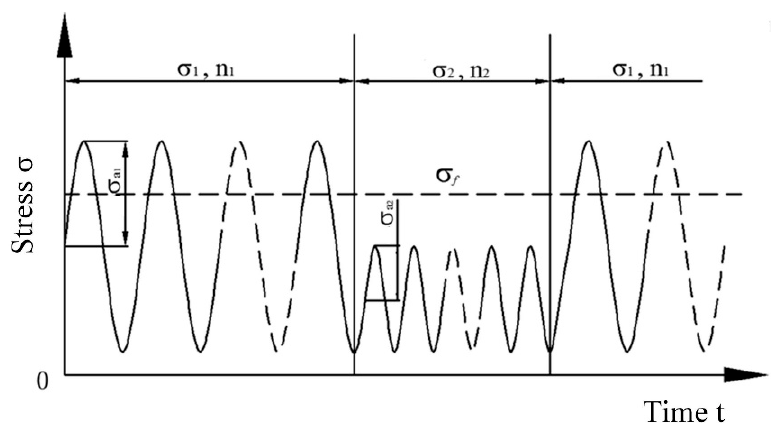
Figure 7. The loading sequence of two-step repeating test.